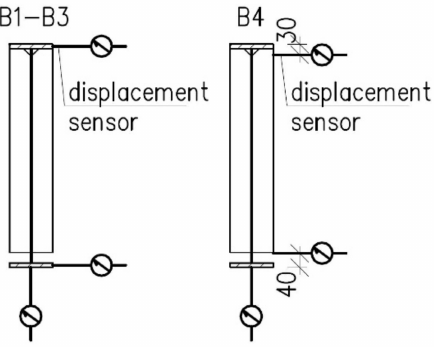
Figure 7. Displacement sensors distribution scheme.